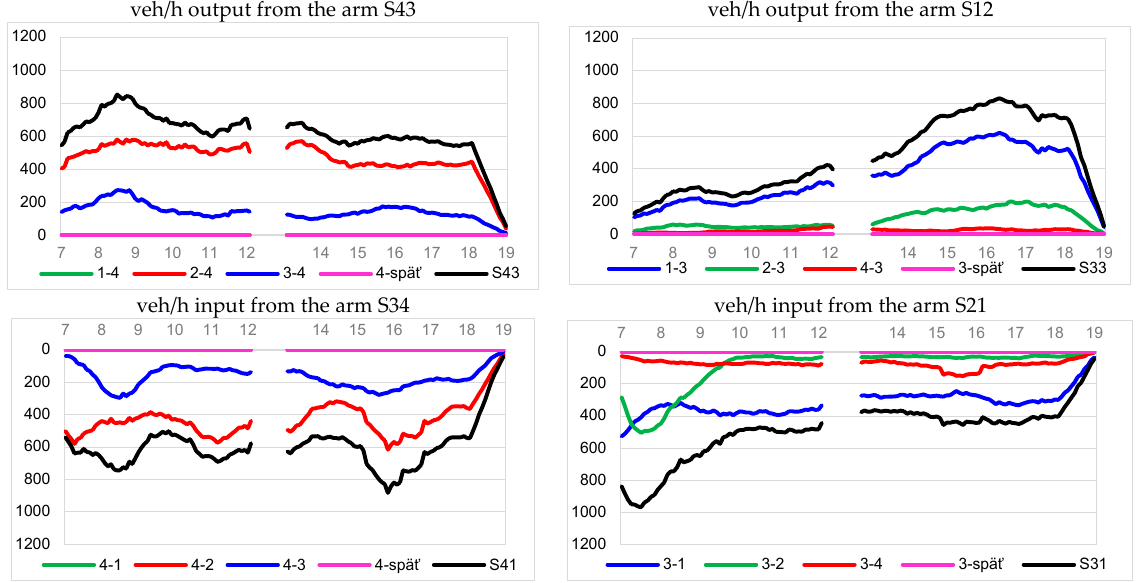
Figure 6. Example of traffic volume output on the entry and exit arms of an intersection. In this way, the traffic engineer or designer has specific junction data with precisely defined traffic flow capacities to size. Spatially, we can imagine that for a simple BIM pro- ject, according to [23], an area with approximately 5–8 intersections and approximately